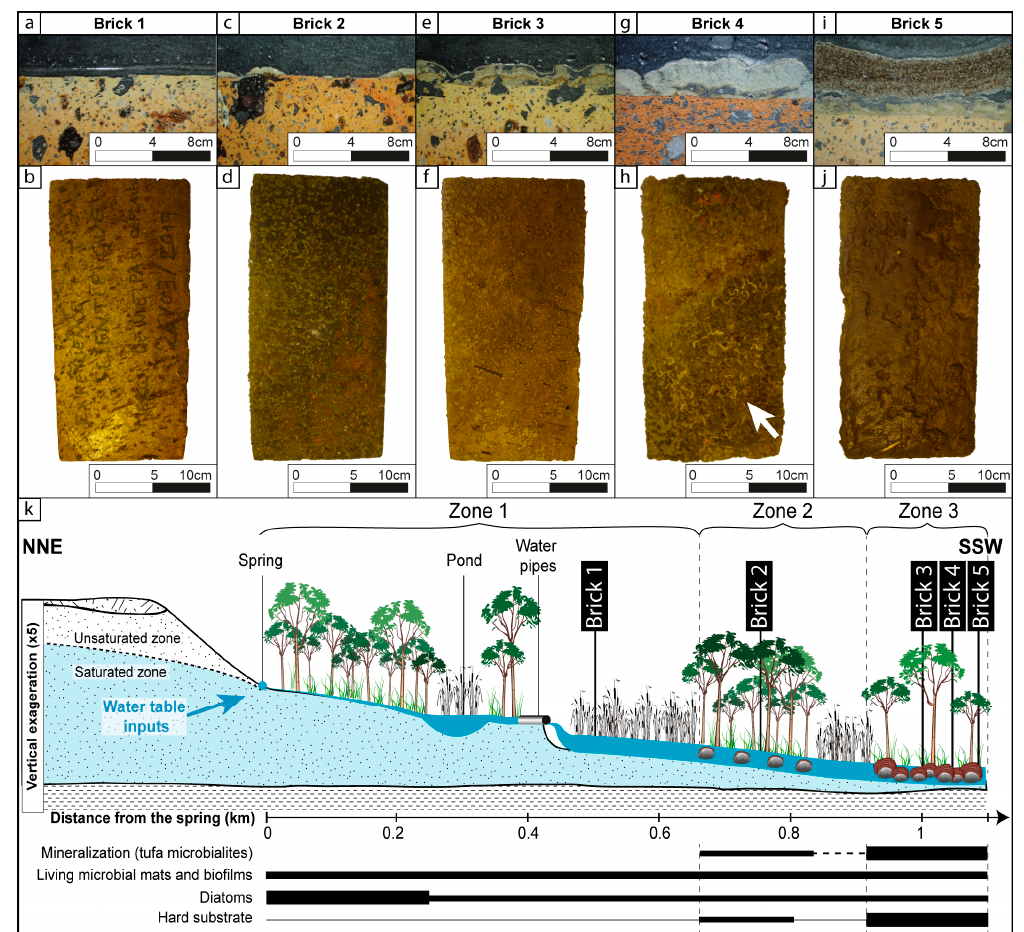
Figure 7. Degree of mineralization along the stream ( a, c, e, g, i : Thin section view of terracotta bricks; b, d, f, h, j : Top view of terracotta bricks): ( a,b ) No mineralization on top brick 1 (Zone 1); ( c ) and ( d ) thin and patchy tufa microbialite on top of brick 2 (Zone 2; forest-dominated); ( e,f ) thin